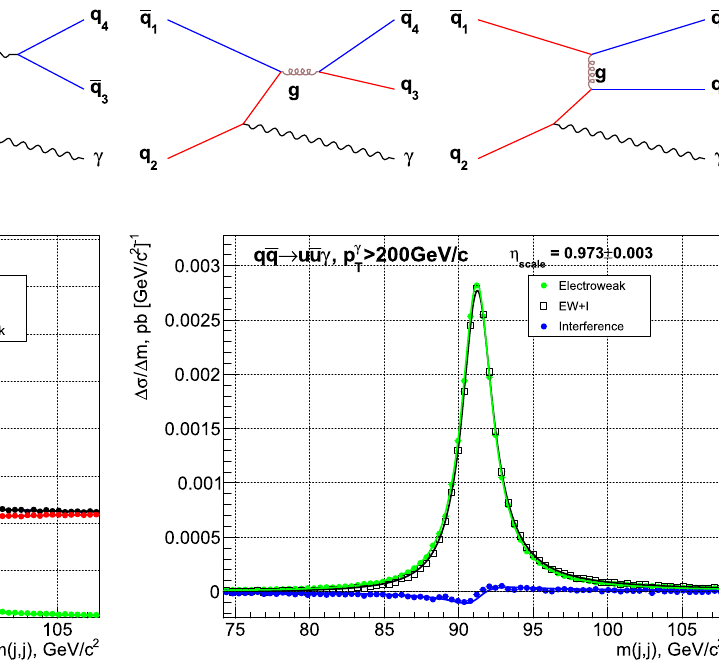
Fig. 9 The cross-section for the process qq → uu γ , with the uu pair required to have p T > 200 GeV/c. Left shows the pure electroweak (pale/green), pure QCD (dark/red) and total (black) cross-sections.